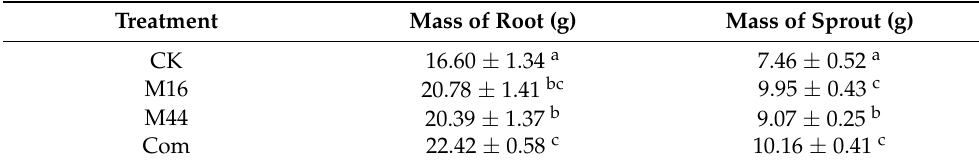
Table 2. Mass of roots and sprouts at D14 after different